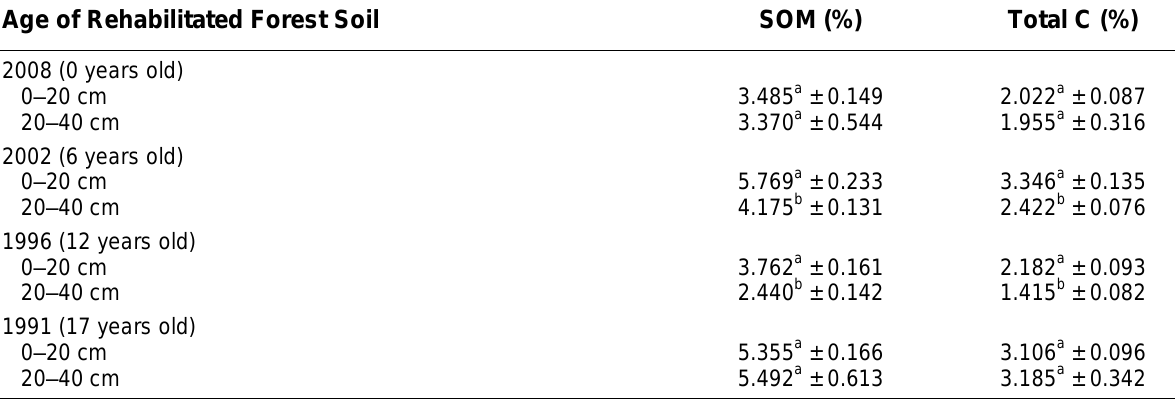
SOM and Total C of a Rehabilitated Forest (between Depths) Age of Rehabilitated Forest Soil SOM (%)